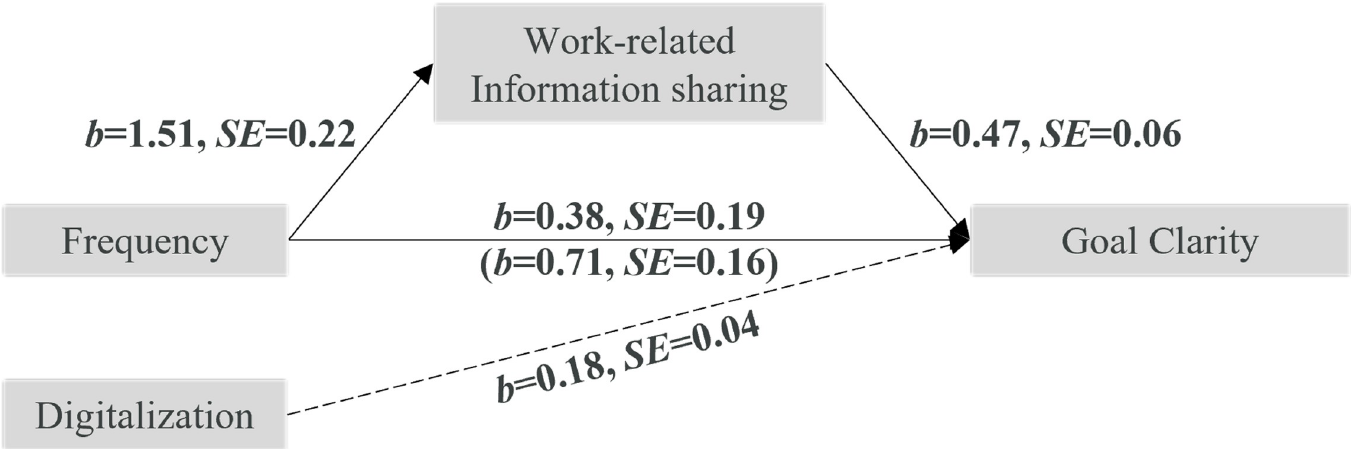
Fig 3. Mediation analysis with outcome goal clarity. Estimates in bold are significant, dashed line represents control variable.